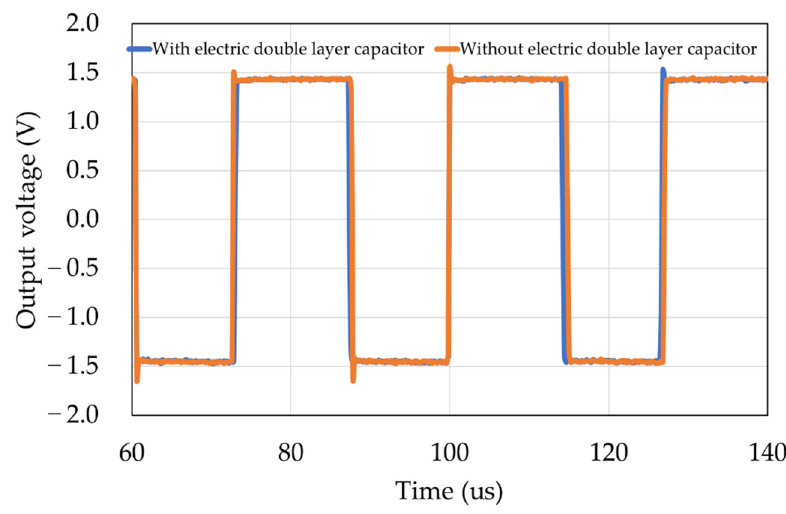
Figure 10. Results obtained with and without the electric double layer capacitor.